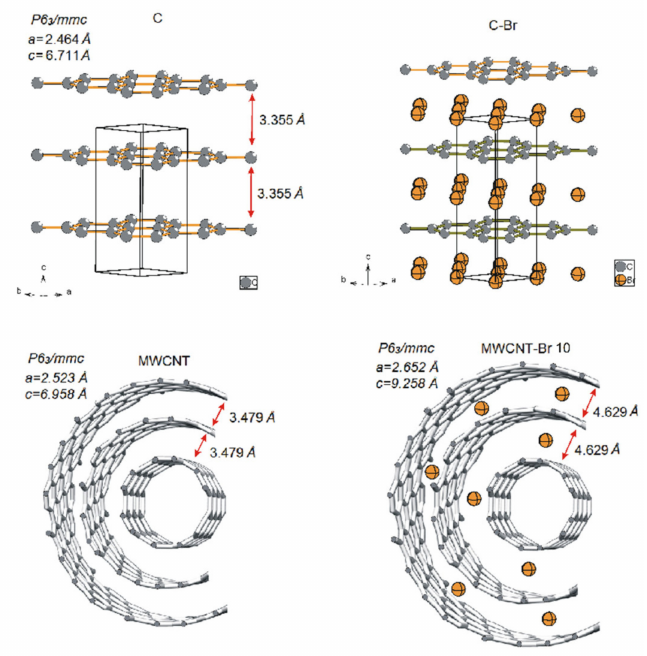
Figure 7. Model structure of native and 10-day-brominated